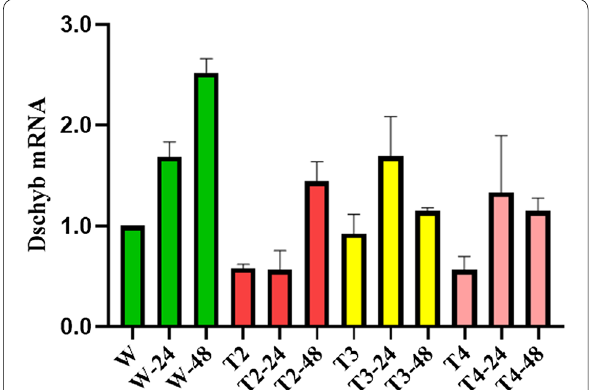
Fig. 5 Relative expression level of Dschyb gene at different times after exposure to high intensity LED light (Values represented as mean SD (n 3)). W, W-24, W-48: The mRNA expression levels ± = of Dschyb in WT strain which exposure to high light for 0 h, 24 h, and 48 h, respectively; T, T-24, T-48: The expression level of Dschyb in mutant which exposure to high light for 0 h, 24 h, and 48 h,